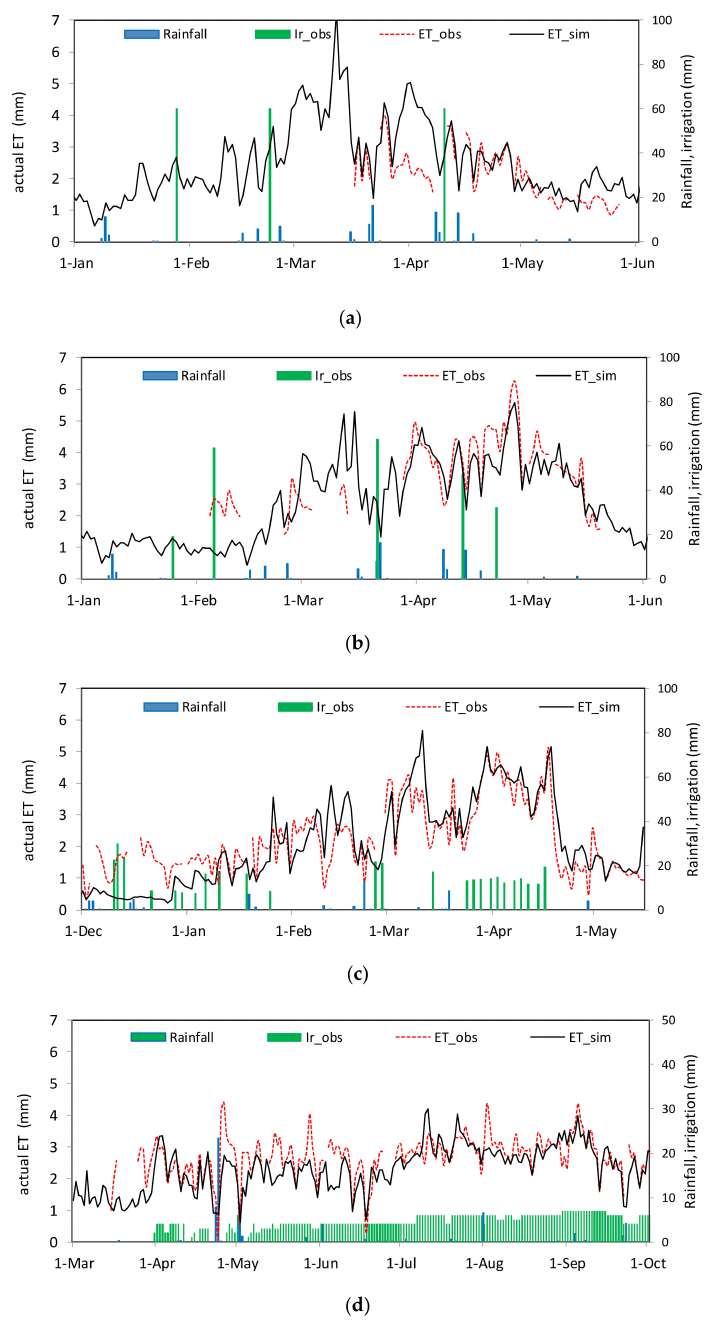
Figure 5. Comparison between measured and simulated actual ET over the validation fields: three wheat fields V1 ( a ) and V2 ( b ) in 2002–2003, V3 ( c ) in 2016–2017), and the olive tree V4 ( d ) in